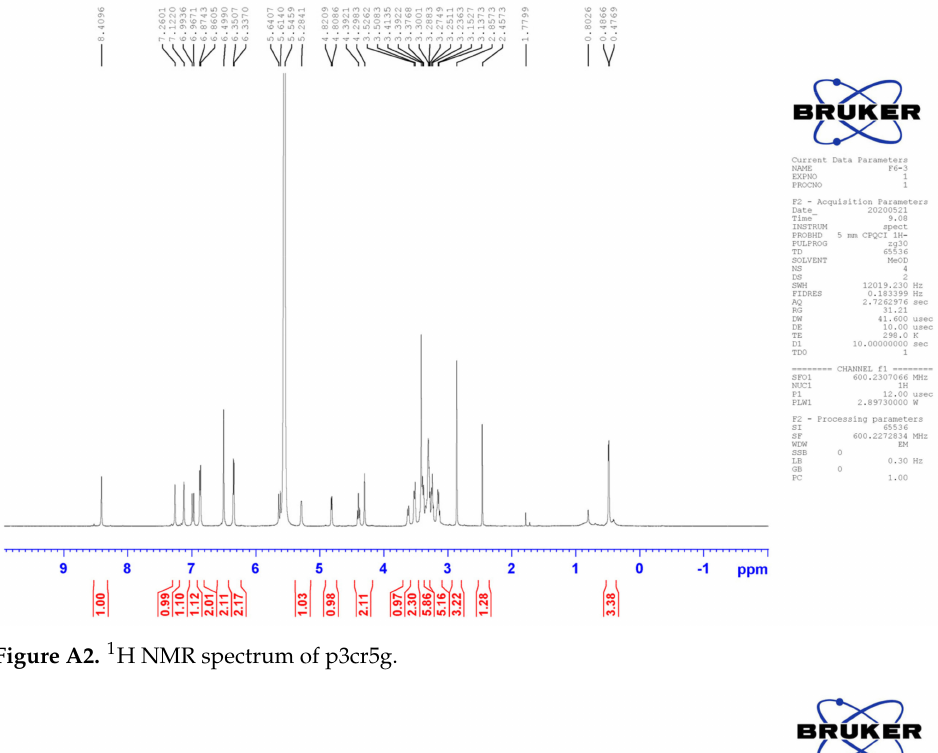
Figure A2. 1 H NMR spectrum of p3cr5g.